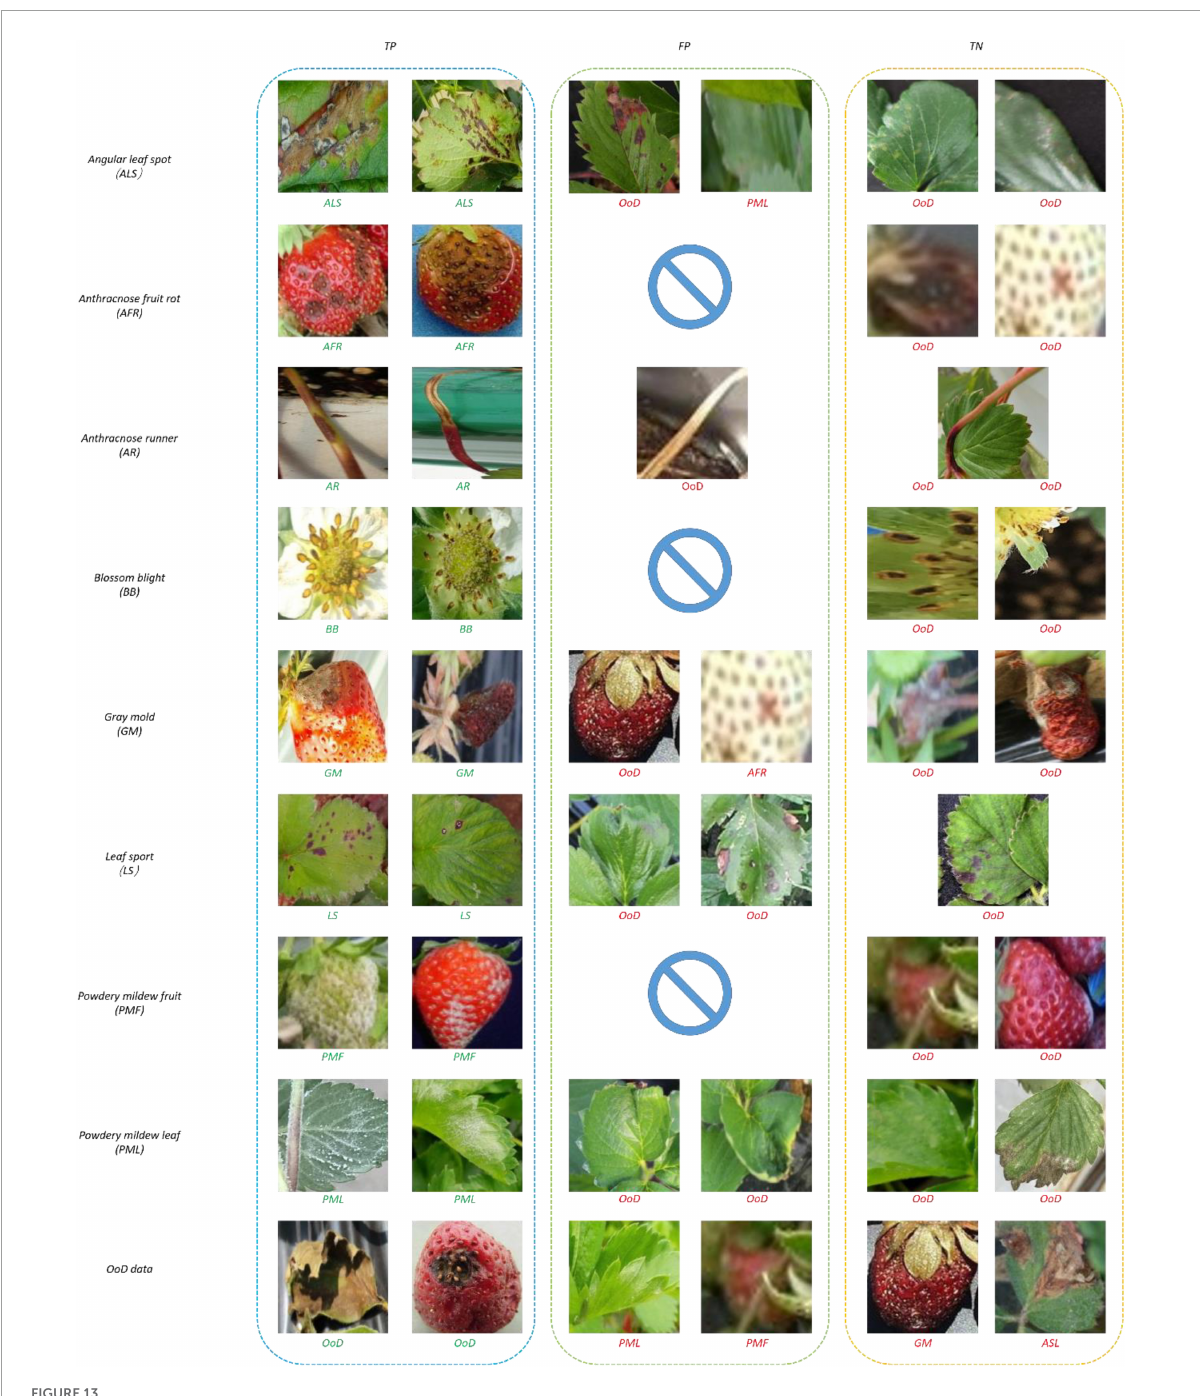
FIGURE13 Recognition results of correct and incorrect classification.